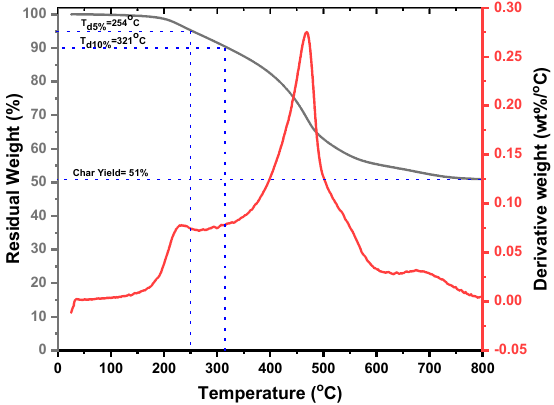
Figure 5. TGA (black curve) and DTG (red curve) thermogram of poly(CA-pdms-fu).